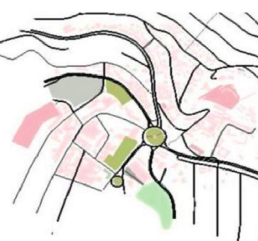
Figure 3: SUMO map.